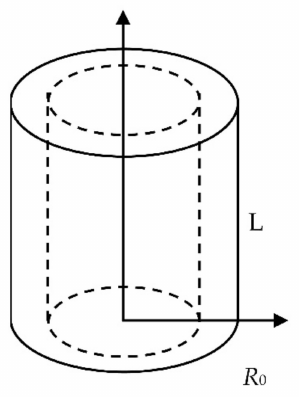
Figure 3. Schematic diagram of cylindrical scrap